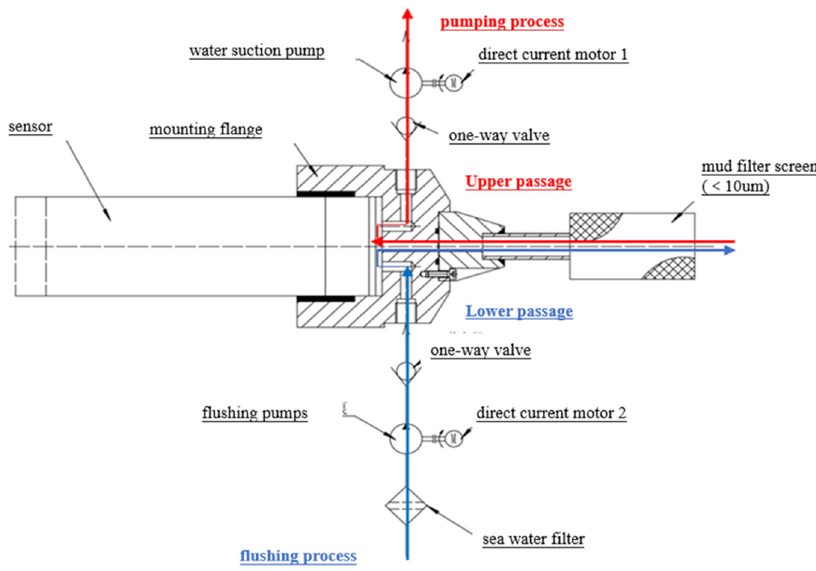
Figure 5. Schematic diagram of suction filtration device design.